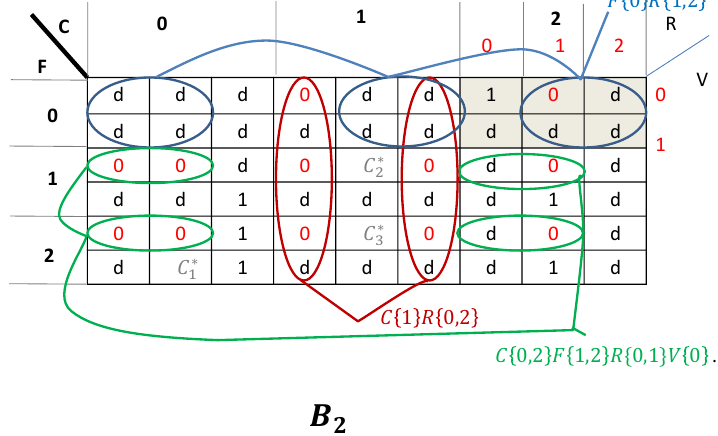
Fig. 7. A multi-valued-Karnaugh-map representation of 𝑩 (implementation of party bans), a translation of 𝟐 Table 3 in Hartmann and Kemmerzell (2010), with loops covering the prime implicants of the negated { } of 𝑩 part 𝑩 , assuming C 1 *= C 2 * = C 3 * = 1 𝟐𝒍 𝟐